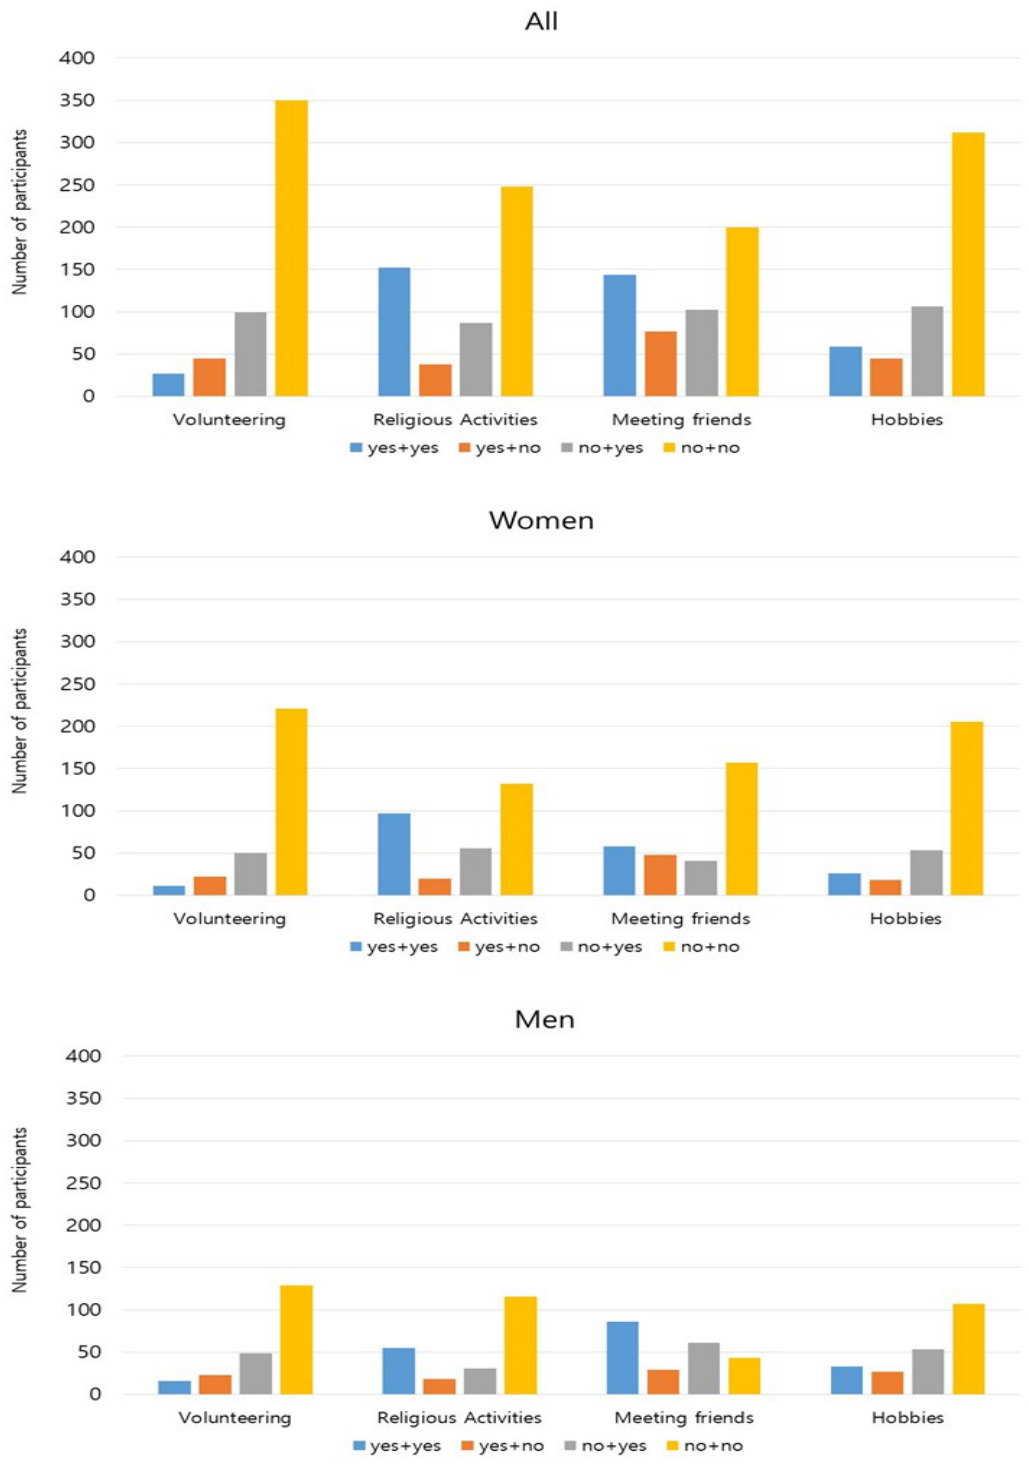
Figure 1. Changes in In-Person Social Activities from Wave 1 to Wave 4. Note 1: yes = participated in the listed activity; no = did not participate in the activity. Note 2: 4 change categories, yes + yes = “yes” in both Wave 1 and Wave 4; yes + no = ‘yes’ in wave 1 and ‘no’ in Wave 4; no + yes = ‘no’ in Wave 1 and “yes” in wave 4; no + no = “no” in both Wave 1 and Wave 4.